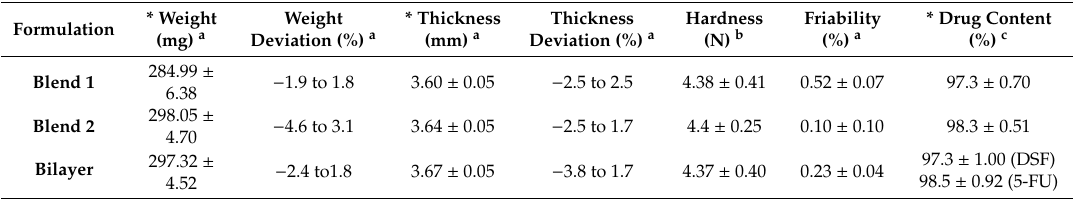
Table 6. Physicochemical properties of single blends and bilayer tablets.